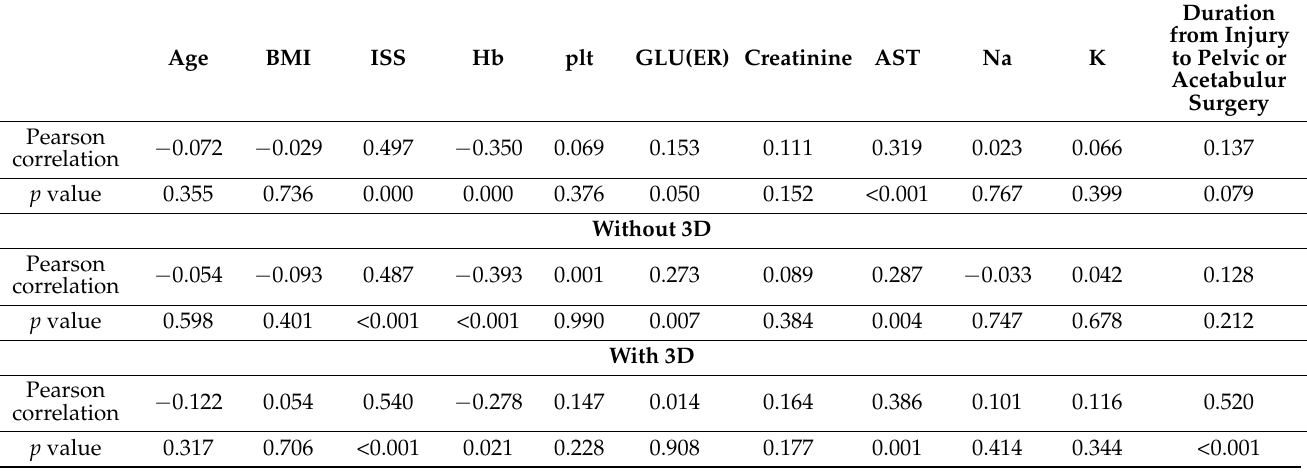
Table 2. Correlation between LHS and parameters.